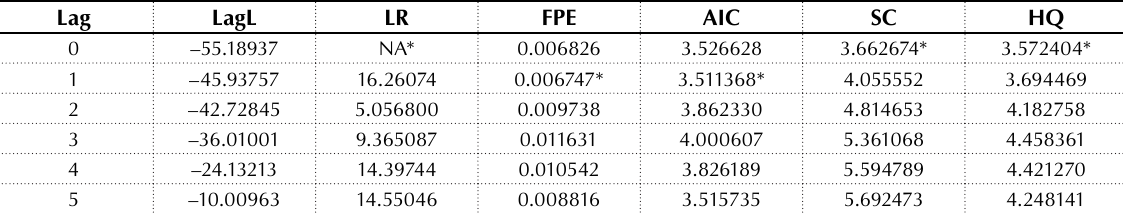
Table 2. Testing model with